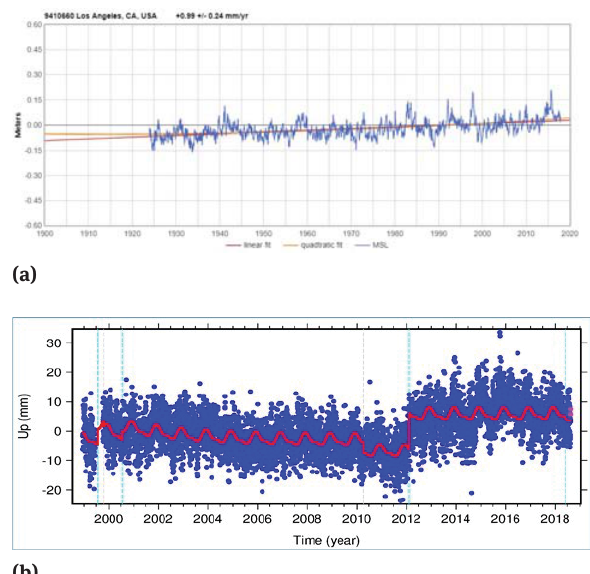
Figure 19: (a) MSL data for Los Angeles, CA, USA. Image reproduced modified after [4]. (b) GNSS time series for VTIS. Image reproduced modified after